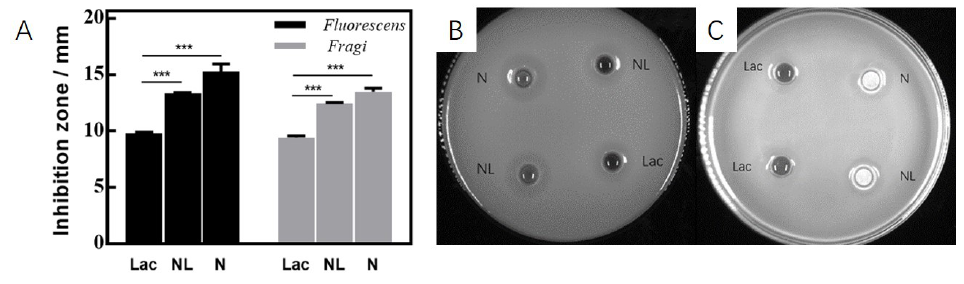
Figure 2. Antibacterial effects of lactic acid against the target Pseudomonas , where ( A ) shows the